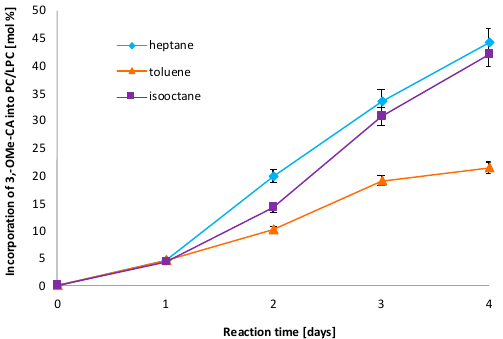
Figure 2. Dependence of incorporation degree of 3-OMe-CA into egg-yolk PC on reaction time for different organic medium (reaction conditions: Novozym 435, 1:5 PC/3-OMe-CA molar ratio, solvent 2 mL, enzyme load 30% ( w / w ), temperature 50 ◦ C, reaction time 1, 2, 3 and 4 days). Vertical bars represent SD, n = 3.